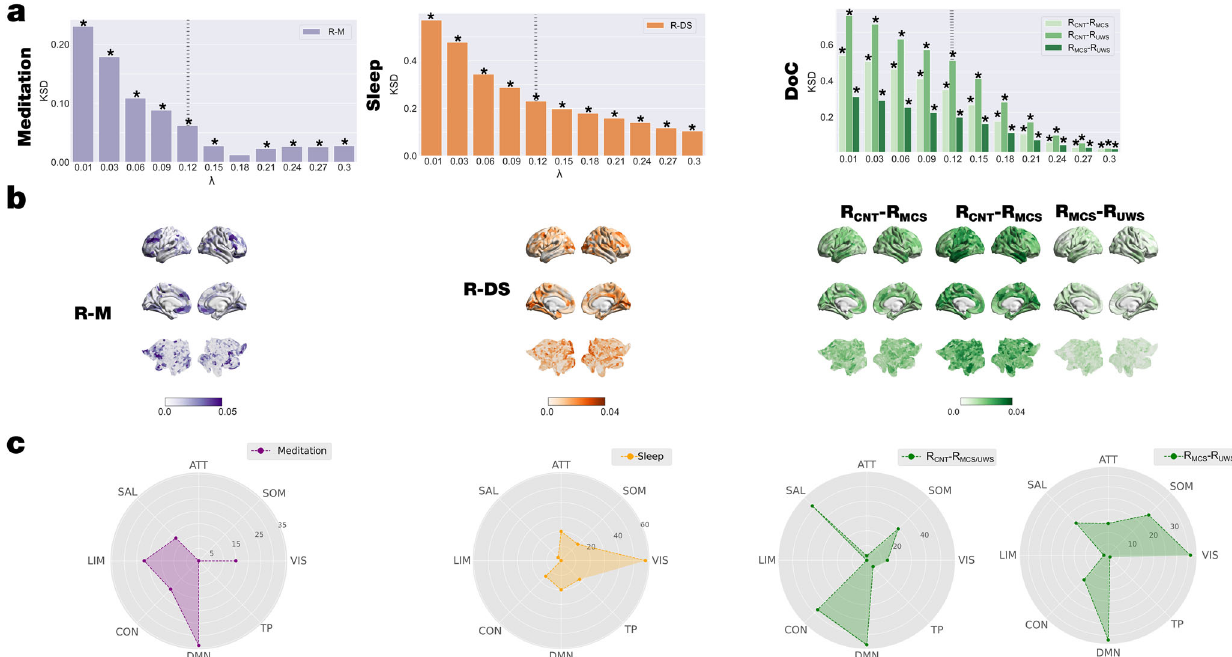
Fig. 4 Local node-level metastability was signi fi cantly different between brain states and revealed distinct signatures of network involvement. We computed the node-level metastability as the standard deviation across time of the local Kuramoto order parameter (see Methods). a We performed the KSD between distributions of the node-level of metastability of each brain state within each dataset for each scale. The KSD for all datasets monotonically decreases, whereas the value of λ increases for all comparisons. b Render brains represent the absolute difference of the node-level metastability between each brain state for scale λ = 0.12, indicated with vertical dashed lines in panel A. We selected the top 15% quantile of absolute differences between conditions, identi fi ed the resting state networks to which they belong and quanti fi ed the number of nodes per network. c Radar plots represent the number of nodes on the top 15% quantile of the absolute difference by each comparison and resting-state network (CON: control; DMN: default mode; TP: temporal-parietal; VIS; visual; SOM: somatomotor; ATT: attentional; SAL: salience; LIM: limbic). The networks showing the highest differences between resting and meditation states were the limbic and default-mode networks. The comparison between deep sleep and resting state shows that nodes of the visual- and default-mode- networks present the highest difference. Finally, the comparison between R CNT and DOC patients ( R MCS and R UWS ) shows that the somatomotor-, salience-, control-, and default-mode- networks present the highest differences, whereas, speci fi cally in the comparison between R MCS and R UWS nodes associated with the somatomotor- and control- networks present the highest differences. P-values were assessed using the Kolmogorov – Smirnov test and corrected for multiple comparisons, * P < absolute difference between the node-level metastability between brain states in each dataset at λ = 0.12 rendered onto the brain cortex (Fig. 4b).